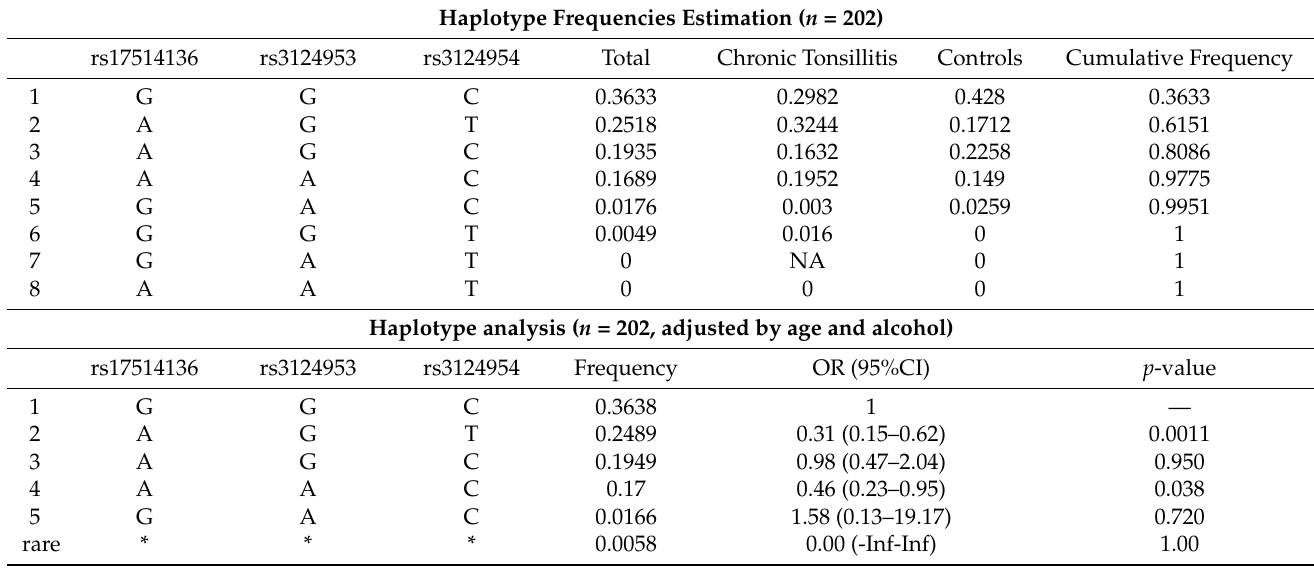
Table 6. Haplotype